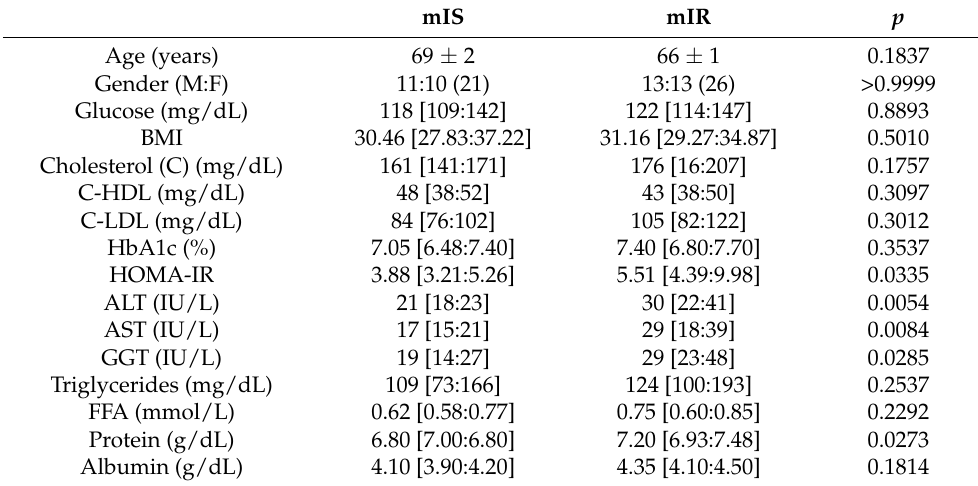
Table 1. Relevant biochemical features of T2D patients indicated as median ± interquartile range (IQR), except for age which is median ± SD.